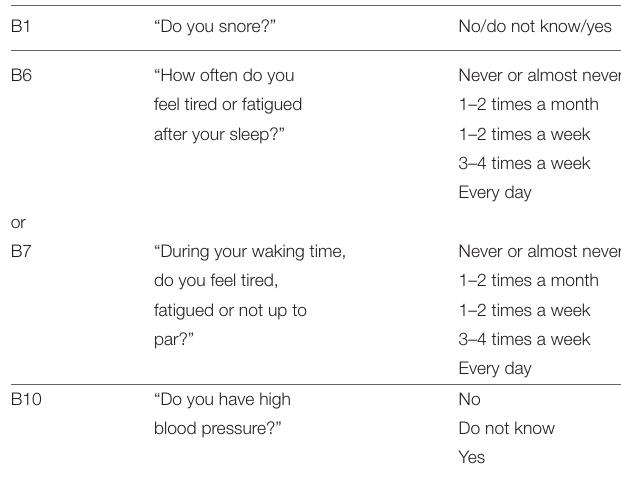
TABLE 4 | Simplified Berlin